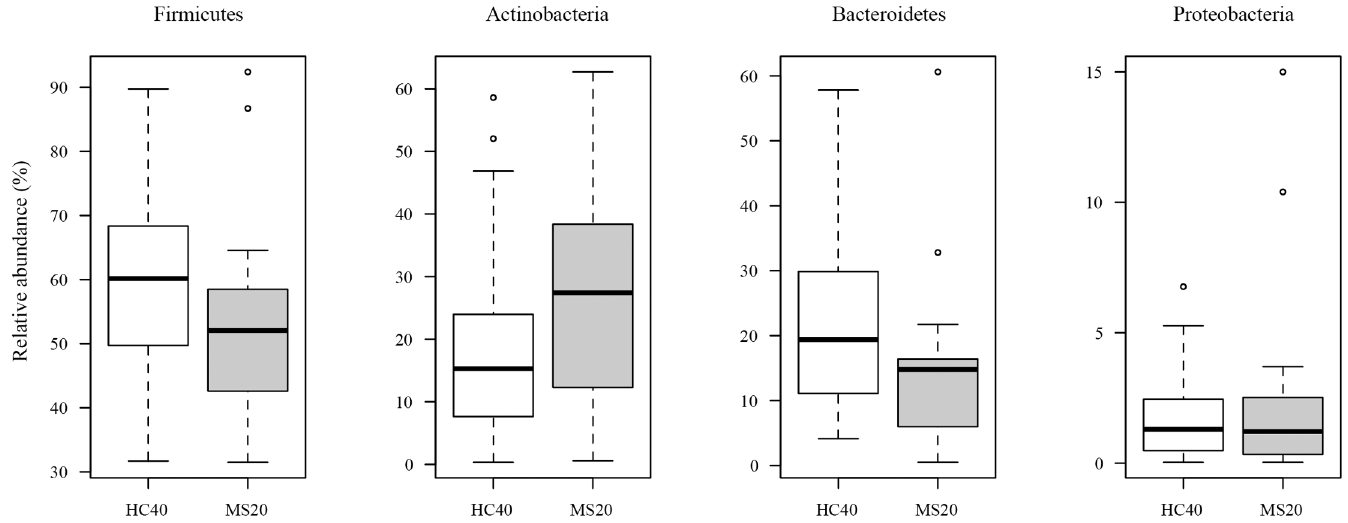
Fig 3. Bacterial composition at the phylum level in gut microbiota samples obtained from HC40 and MS20 subjects. For phylum-level assignment of 16S reads (16S rRNA gene V1-V2 region) mapped to the known FL-16S sequences and unmapped OTUs (see Results), 70% sequence identity threshold was applied. The vertical axis represents the relative abundance of each phylum in the microbiota of HC40 (open bar) and MS20 (grey bar) subjects. Each box plot represents median, interquartile range, minimum, and maximum values.